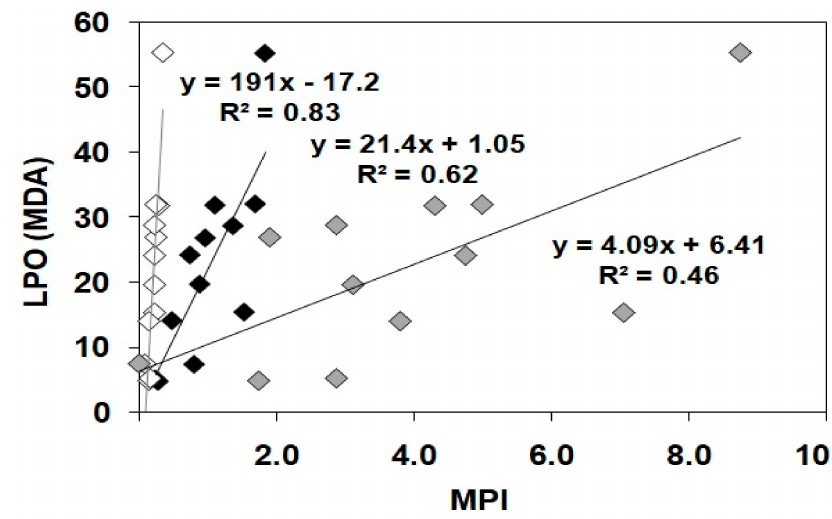
Figure 3. The plot of correlation between MPI and LPO levels for U. laetevirens collected in the three VL sites. Solid white squares (cid:3) indicated MPI/concentration of Hg alone, solid black squares (cid:4) indicated MPI calculated for As, Hg and Pb together, and solid gray squares (cid:4) indicated the MPI calculated for the overall